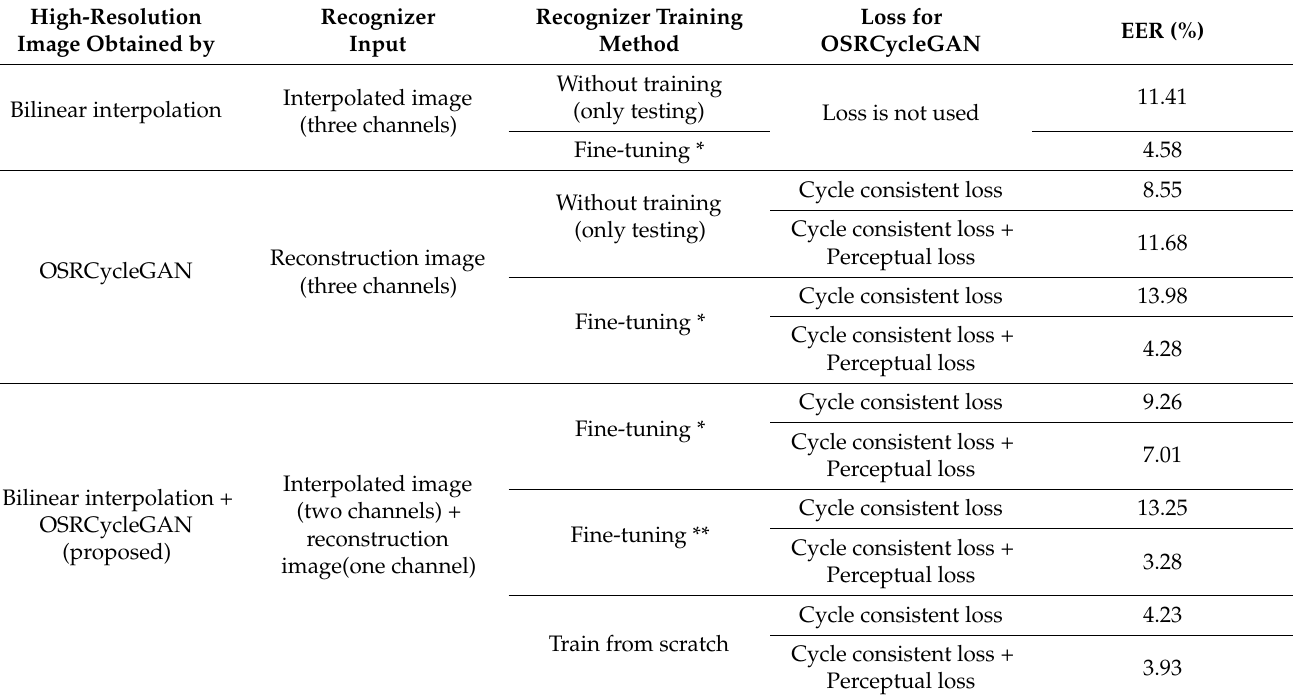
Table 6. Ocular recognition accuracy comparison in the case of using only bilinear interpolation when generating a low-resolution image (* means fine-tuning using the model pretrained with original high-resolution ocular images, and ** means fine-tuning using the model pretrained with